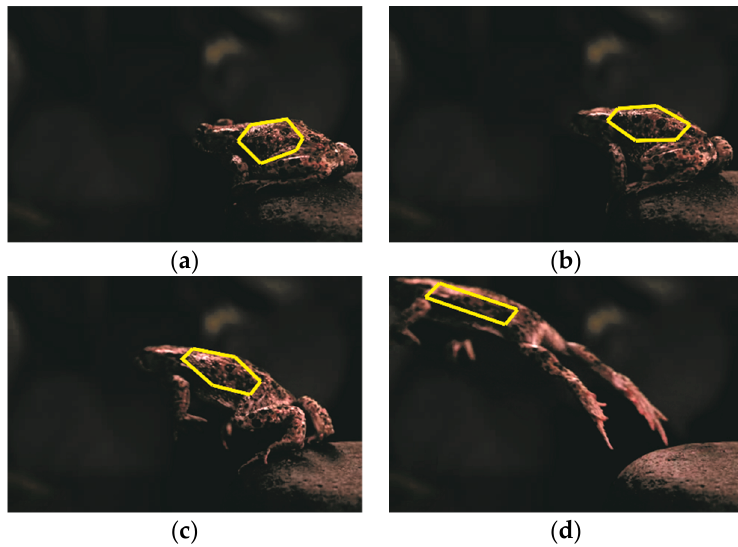
Figure 1. The observation of jumping motion of the frog. ( a ) Contracting trunk; the frog is in a crouched position and ready to jump; ( b ) Begin expanding trunk; the frog lifts its fore legs and begins to jump; ( c ) Expanding trunk; the frog gradually expands its trunk and hind legs; ( d ) Expanding